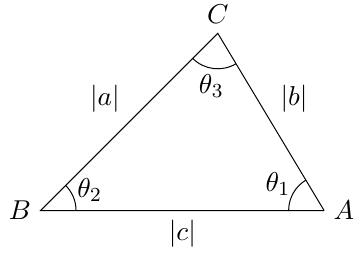
Figure 2 . Triangle for the clover